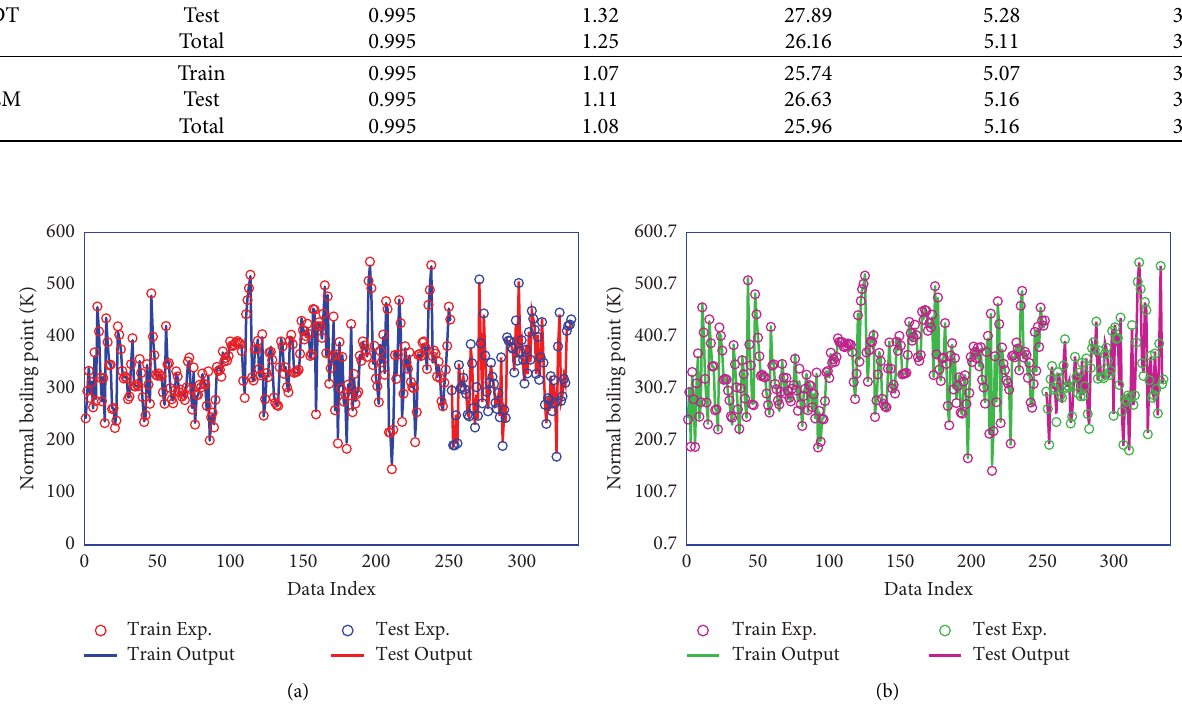
Figure 3: Simultaneous comparison of estimated and actual normal boiling point. (a) EDT boosted and (b)